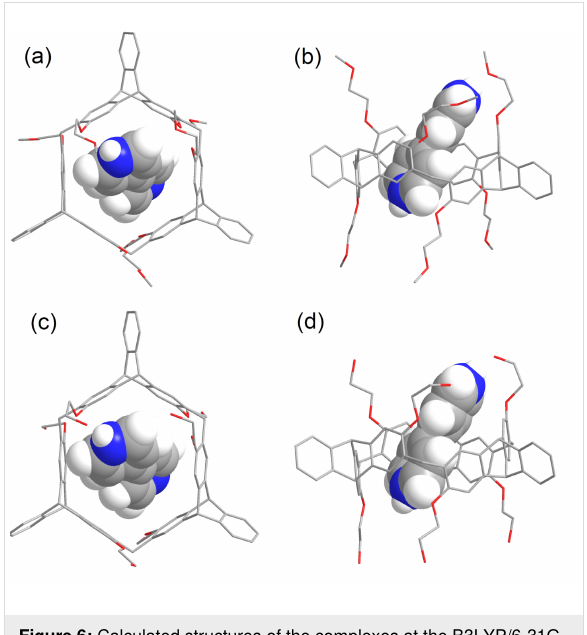
Figure 6: Calculated structures of the complexes at the B3LYP/6-31G level of theory. (a) Top view and (b) side view of H4·G3 , and (c) top view and (d) side view of H5·G3